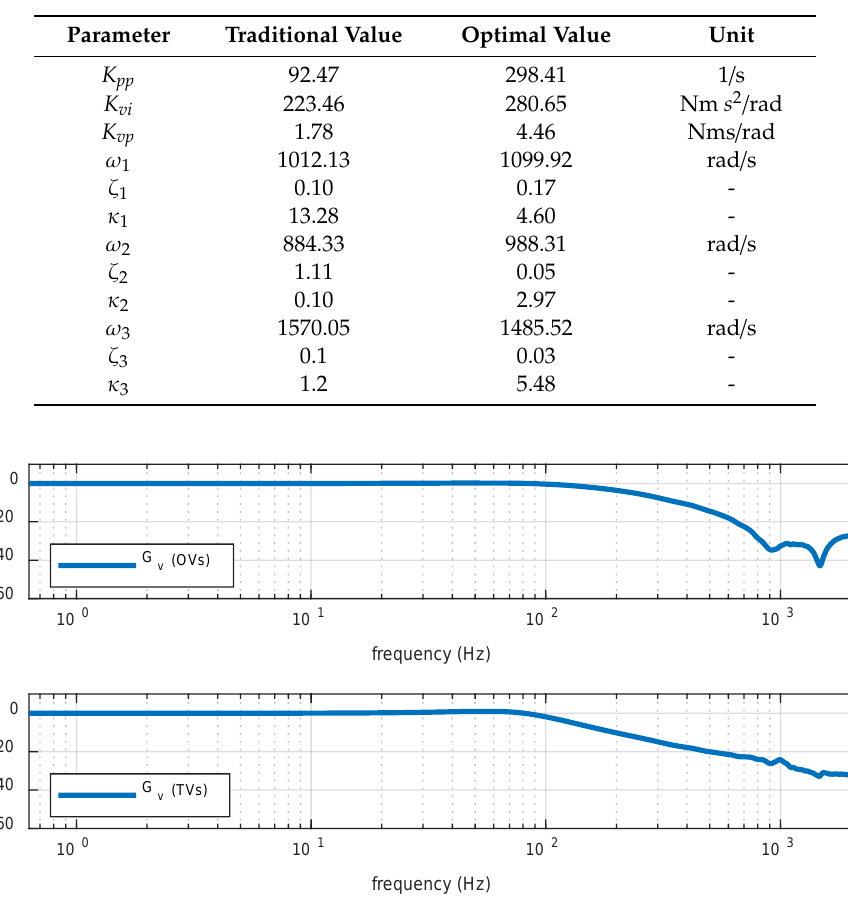
and with TVs and OVs. 𝐺𝐺 𝑣𝑣 𝐺𝐺 𝑣𝑣𝑣𝑣